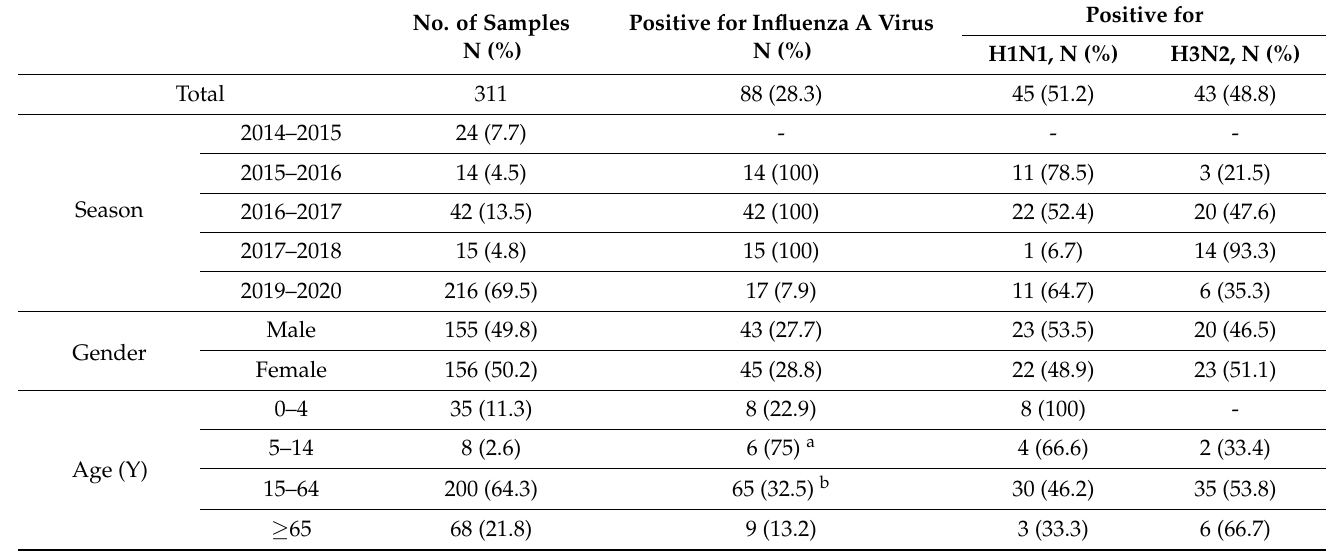
Table 2. Distribution of samples within epidemic seasons, gender, and age groups. No. of